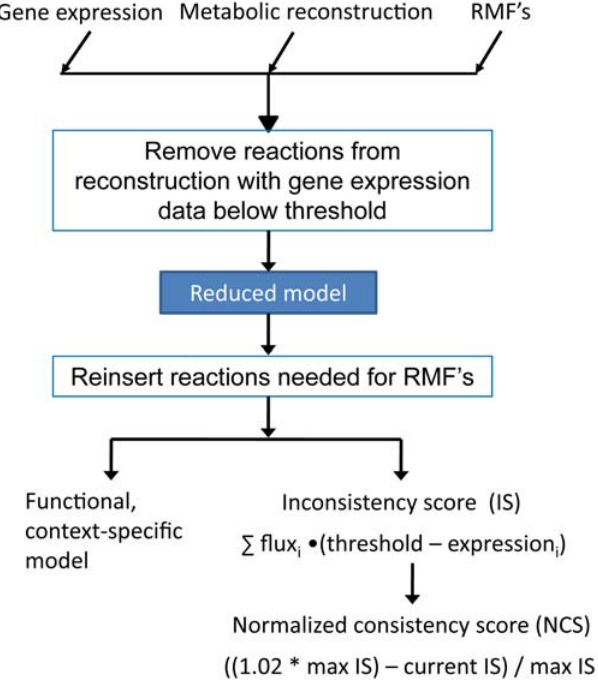
Figure 1. A flow chart schematic representation of the GIMME algorithm. The GIMME algorithm takes three inputs: gene expression (or any other data type) mapped to reactions, a metabolic reconstruc- tion, and one or more RMFs. A metabolic reconstruction is mapped through a data set, removing reactions that are not available and creating a reduced model. Reactions are reinserted into the reduced model as needed to achieve RMFs (such as growth and/or ATP production), resulting in a functional, context-specific model that features minimal disagreement with the data. The consistency score quantifies the disagreement with data, showing the minimal sum of fluxes weighted with reaction data deviations from data.